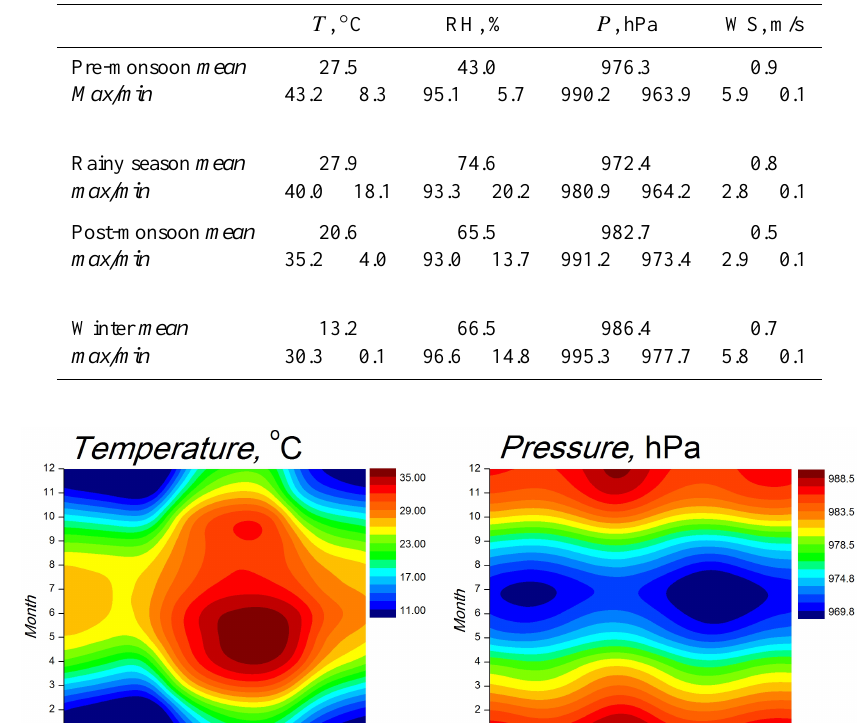
Table 1. Mean, minimum and maximum (1h average) temperature, T , relative humidity, RH, pressure, P , and wind speed, WS during different seasons.